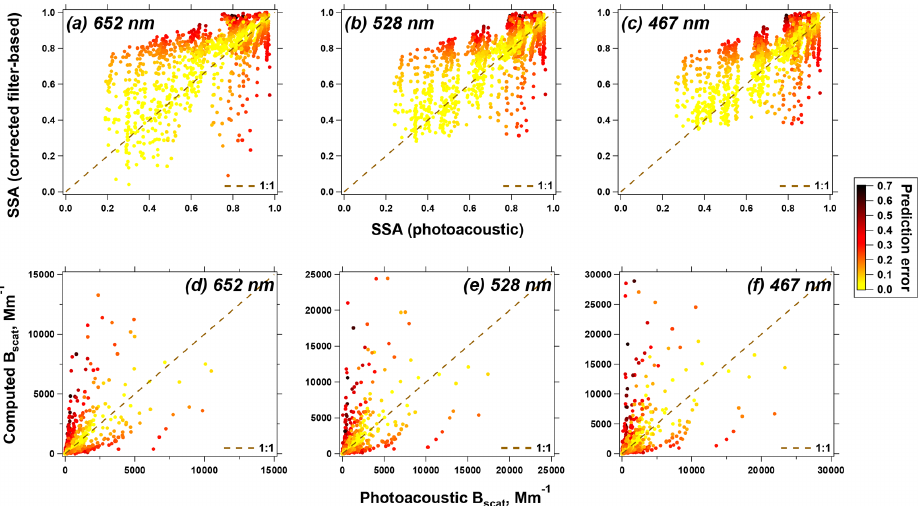
Figure 7. Comparison of SSA (a–c) and B scat (d–f) at the three wavelengths for the FIREX data. Vertical axis: values output from Algorithm C; horizontal axis: values calculated using the photoacoustic B abs and B scat